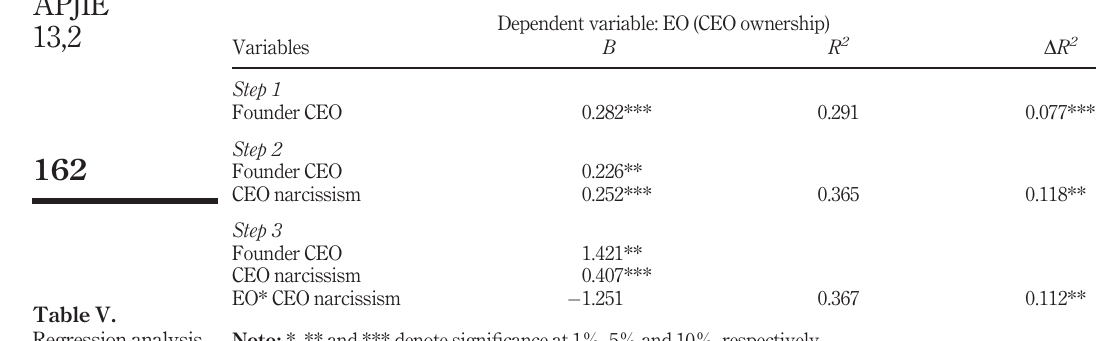
Table V. Regression